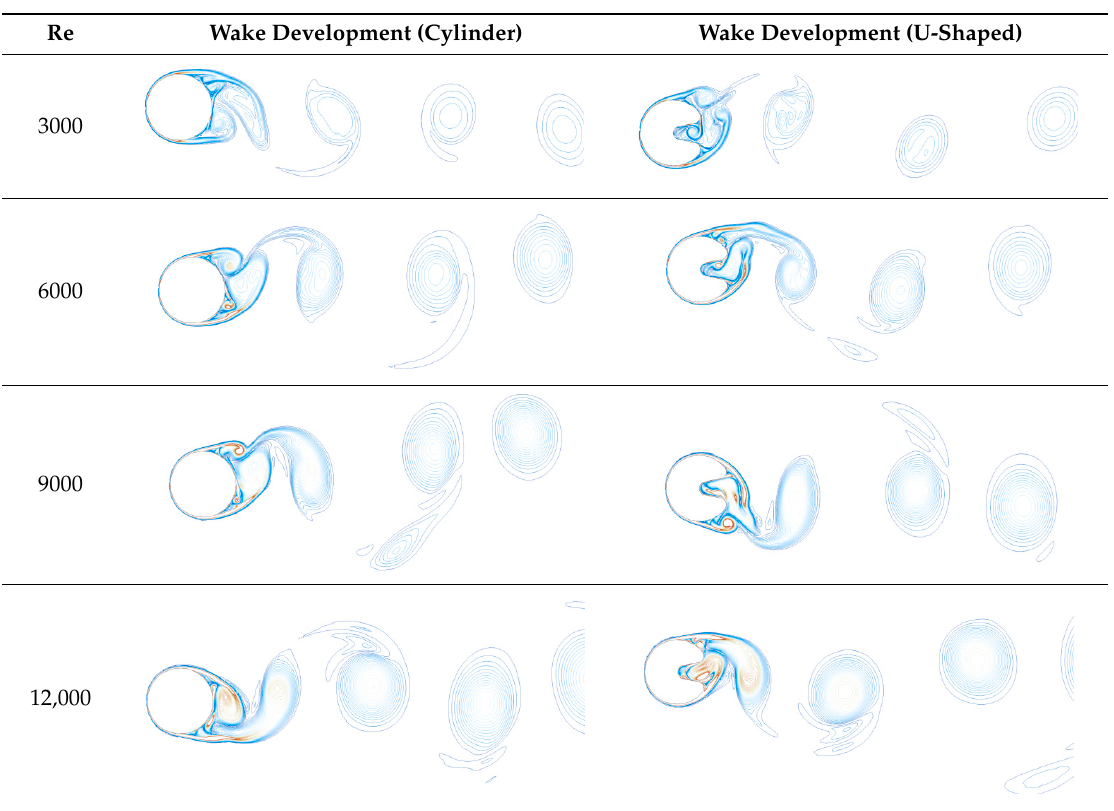
Table A2. Vortex shedding comparison behind the circular cylinder and the U-shaped geometry at different Reynolds numbers where D = 20 mm.